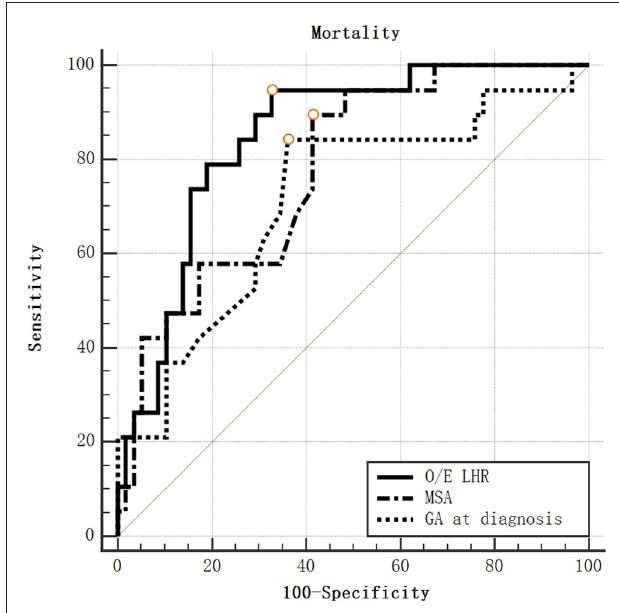
FIGURE 3 | ROC curve for mortality by O/E LHR, MSA value, and GA at diagnosis.